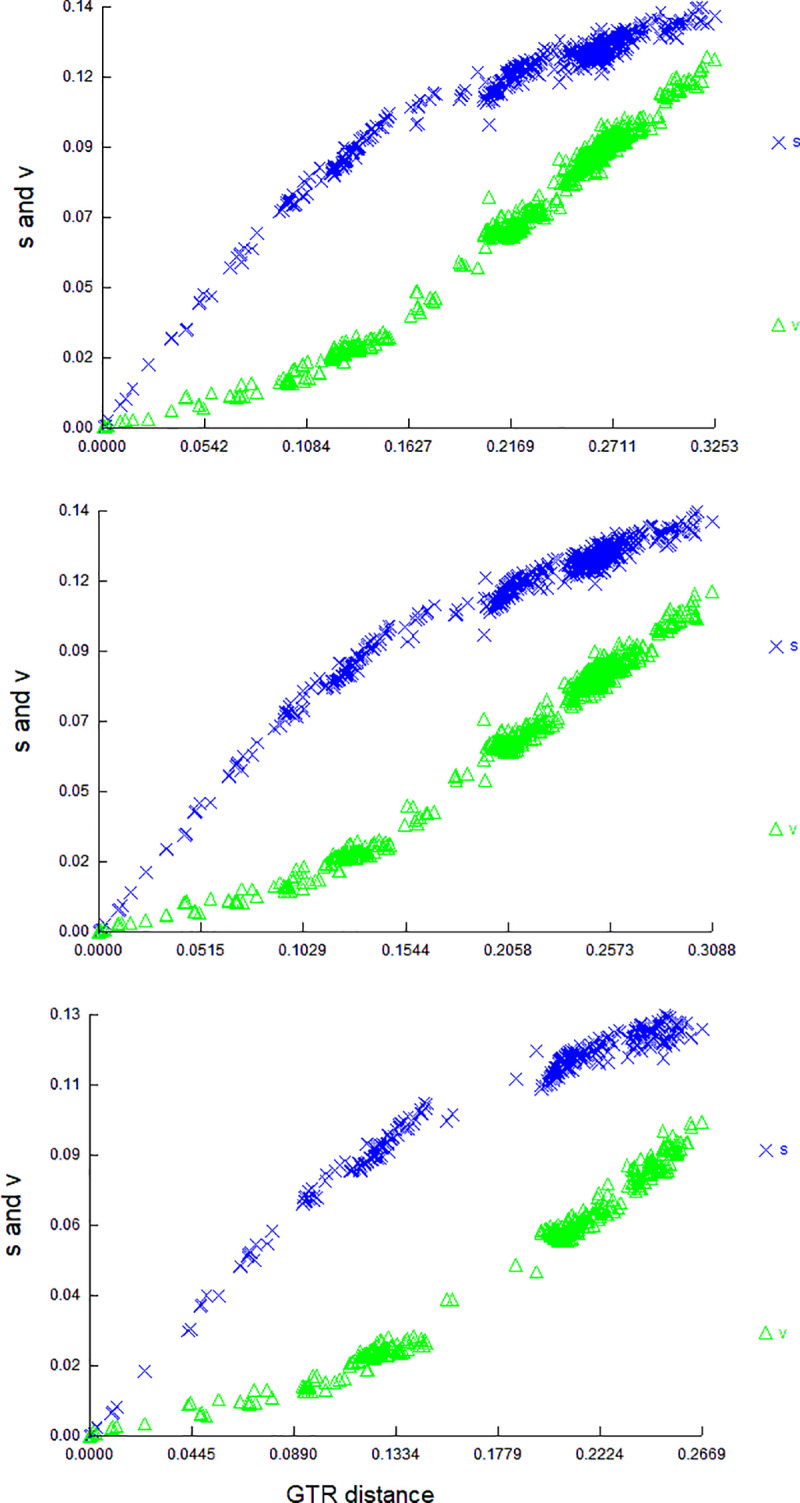
Saturation curves for transitions and transversions.Upper panel—the distances among both ingroup and outgroup taxa, full mitogenome without control region; middle panel—the distances among the ingroup and outgroup taxa, full mitogenome without control region and four the most saturated genes: ATP8, ND2, ND3, and ND1. Lower panel—the distances among Lacertini (Eremias excluded), full mitogenome without control region and four the most saturated genes.